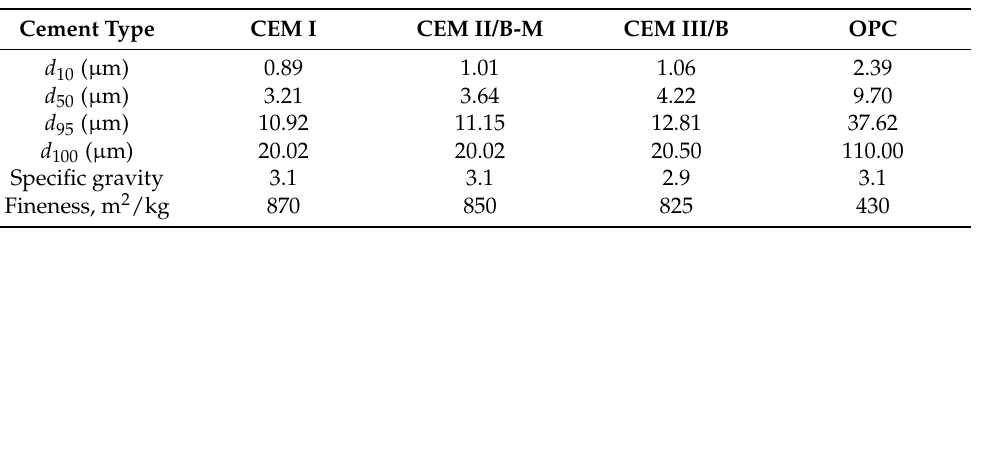
Table 2. The physical properties of different microfine cements in this